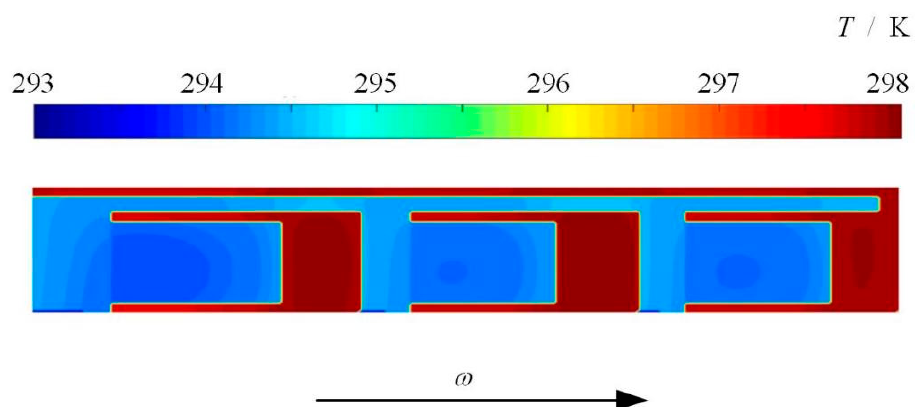
Figure 2. Film temperature distribution obtained by present model for the reference split floating ring seal with pocket depth 10 μ m [20]. ( p i = 0.1 MPa, p o = 0.6 MPa, ω = 1000 s − 1 , T in = 293 K, T out = 293 K).